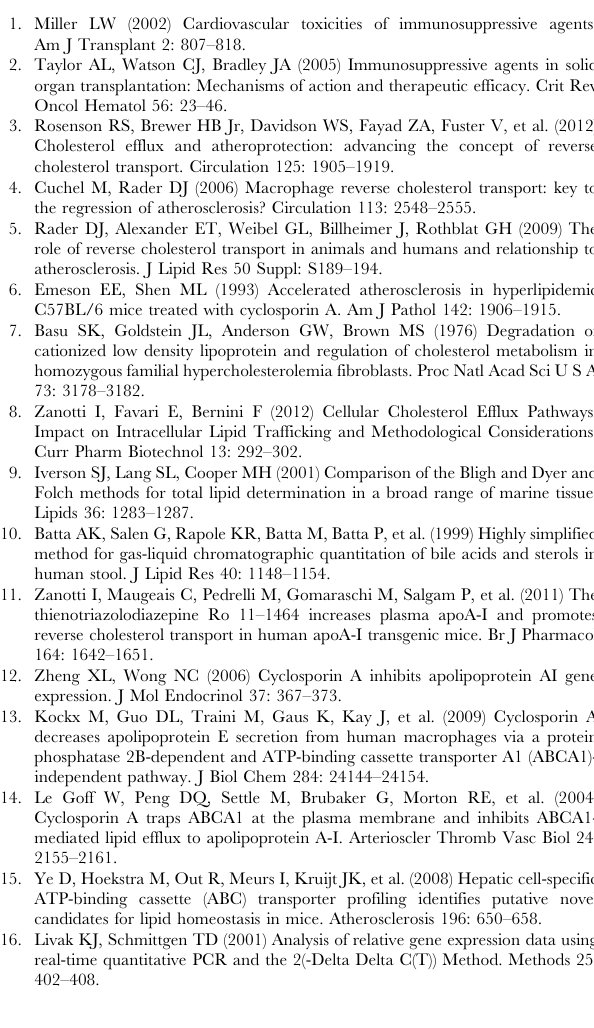
day 7 and on day 14 of the pharmacological treatment. Data are presented as mean 6 SD (n=